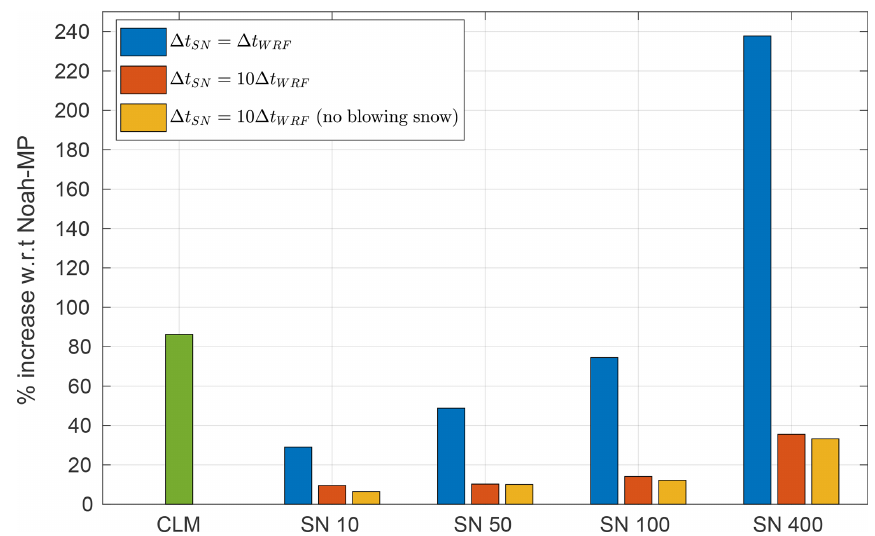
Figure 3. Runtime cost of CRYOWRF. Percentage increase in runtime due to increasing number of simulated snow layers. Number of snow layers simulated are 10, 50, 100, and 400 layers. The percentage increase is calculated with respect to a simulation with Noah-MP being treated as a baseline. An additional comparison with CLM model is also shown. Different coloured bars represent the computational overhead without (blue bars) and with SNOWPACK’s variable time step (red bars), along with the overhead of simulating blowing snow (yellow